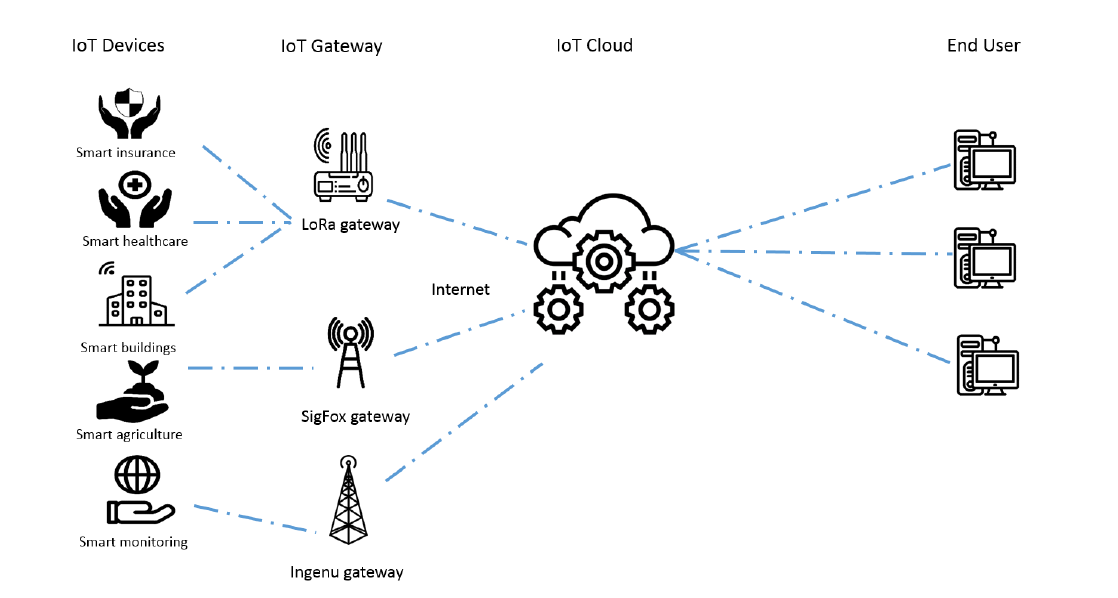
Figure 1. Long-range IoT commercial solutions architecture (icons are adopted from the Noun project website